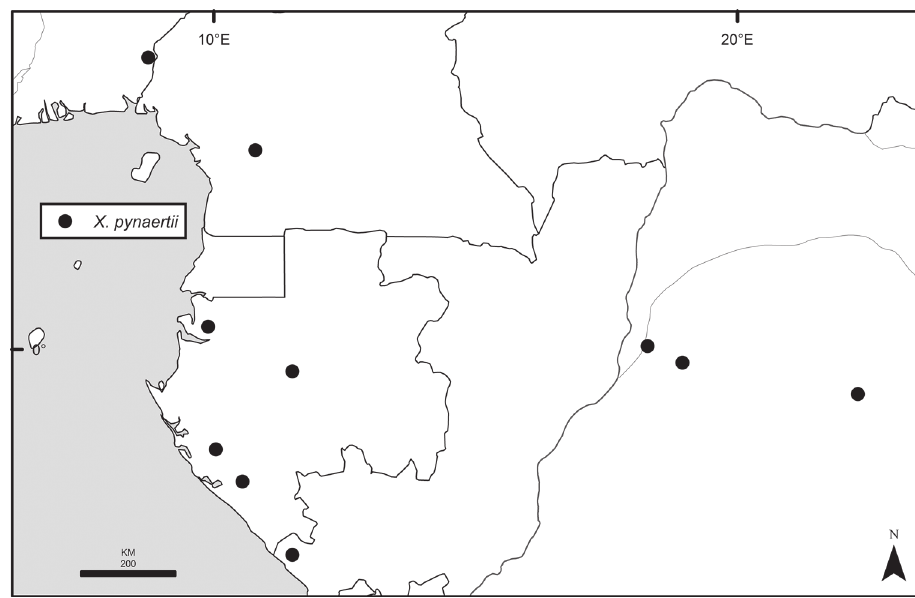
Figure 47. Distribution of Xylopia pynaertii . Bolder lines represent country borders, fainter lines lakes and major